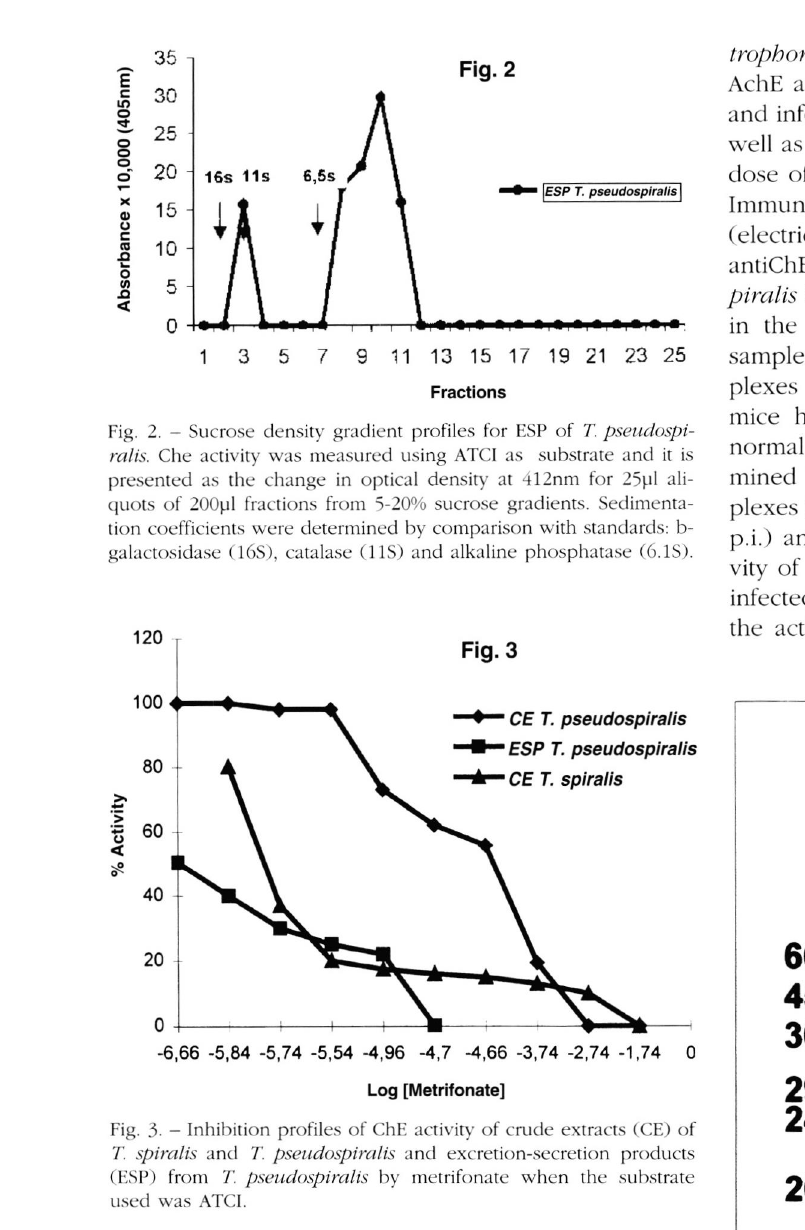
Fig. 3. – Inhibition profiles of ChE activity of crude extracts (CE) of T. spiralis and T. pseudospiralis and excretion-secretion products (ESP) from T. pseudospiralis by metrifonate when the substrate used was ATCI.